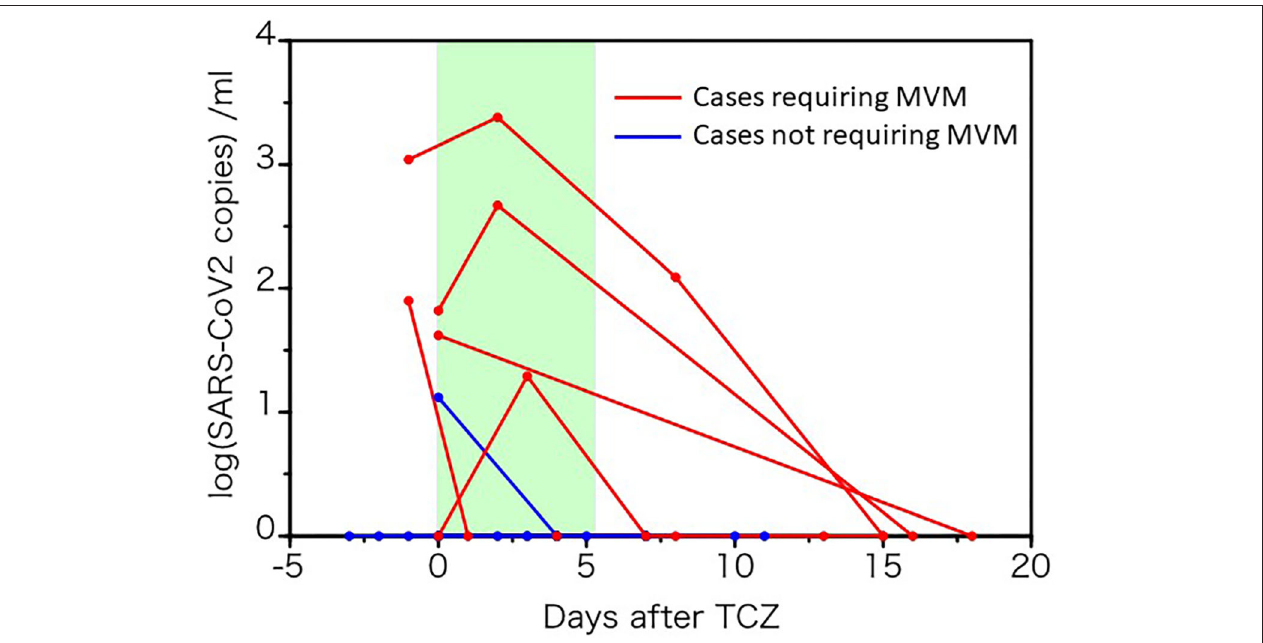
FIGURE 6 | Changes in SARS-CoV-2 load before and after tocilizumab administration. Viral RNA in the sera of 10 patients with COVID-19 patients before and after tocilizumab administration were quantified by RT-PCR. The red line represents the data of patients requiring mechanical ventilation.